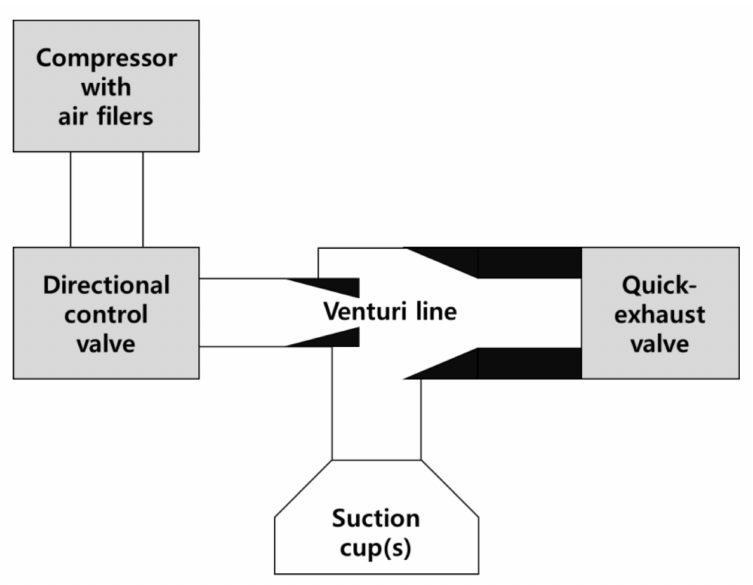
Figure 1. Illustration of a vacuum gripper system (composed with a suction cup and the connected Venturi